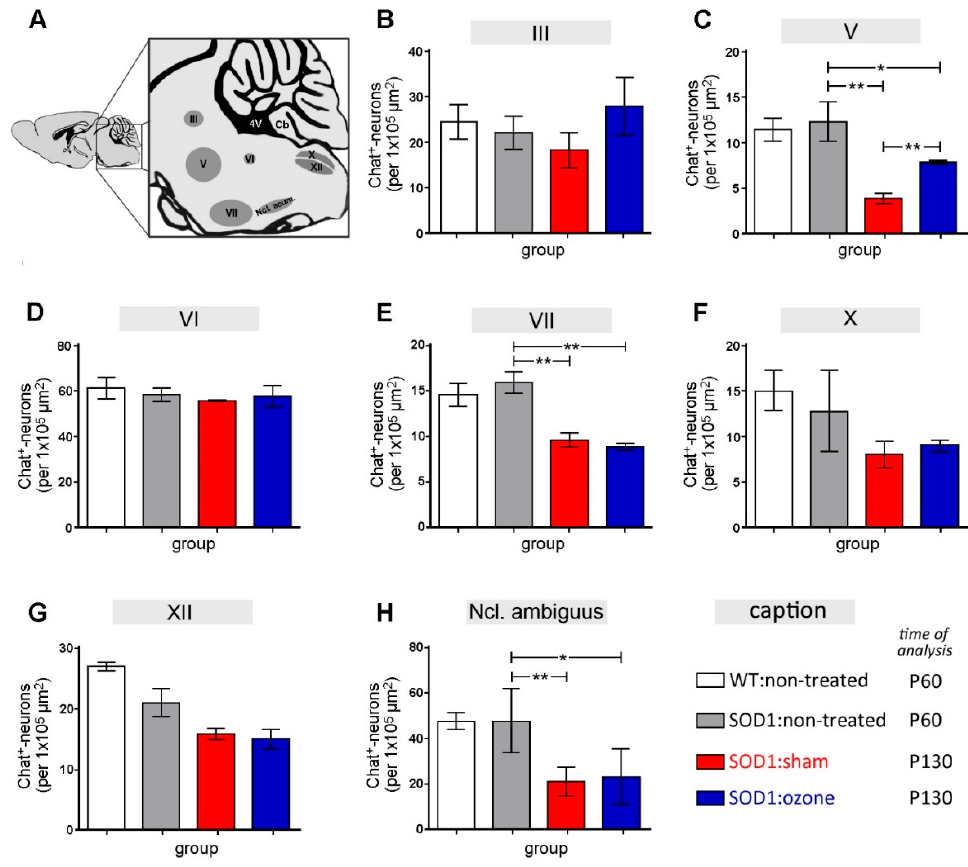
Figure 2. Effect of ozone treatment on motor neuron degeneration in the brainstem of SOD1 G93A mice. ( A ) Diagram showing the location of brainstem motor nuclei analyzed. ( B – H ) Evaluation of motor neuron degeneration in the ( B ) oculomotor (III), ( C ) trigeminal (V), ( D ) abducens (VI), ( E ) facial (VII), ( F ) vagal (X), ( G ) hypoglossal (XII), and ( H ) ambiguus nuclei by determining the number of ChAT-ir cell bodies within each nucleus. The identity of the four experimental groups is shown under the caption. Differences between groups ( n = 3 for all groups) were analyzed using an unpaired t-test with Welch’s correction. Statistical differences (* p < 0.05; ** p < 0.01).